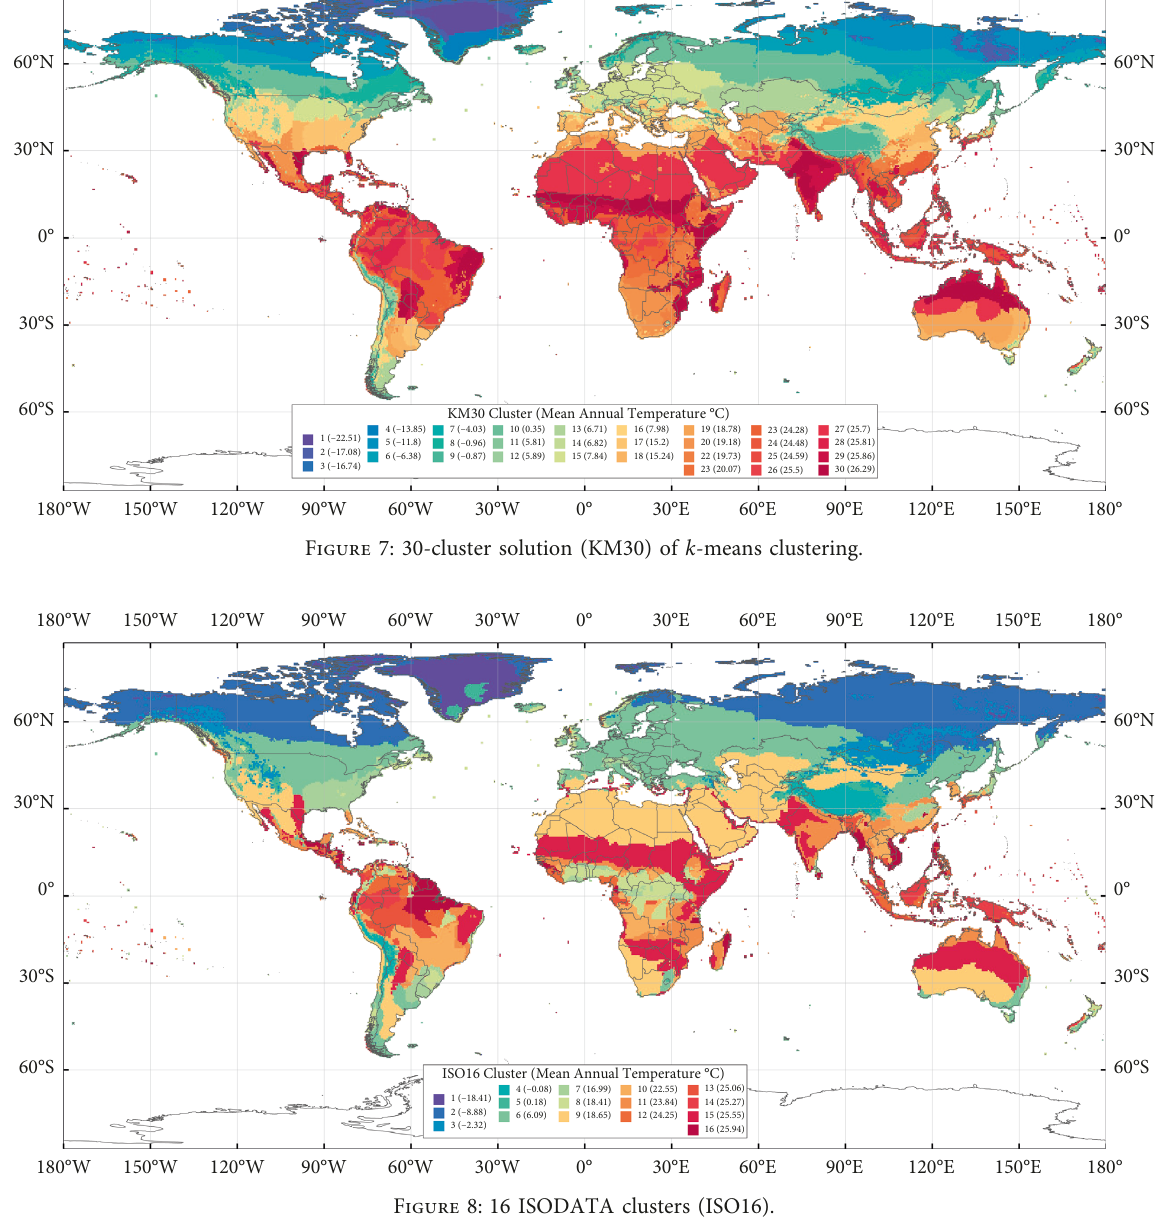
Figure 8: 16 ISODATA clusters